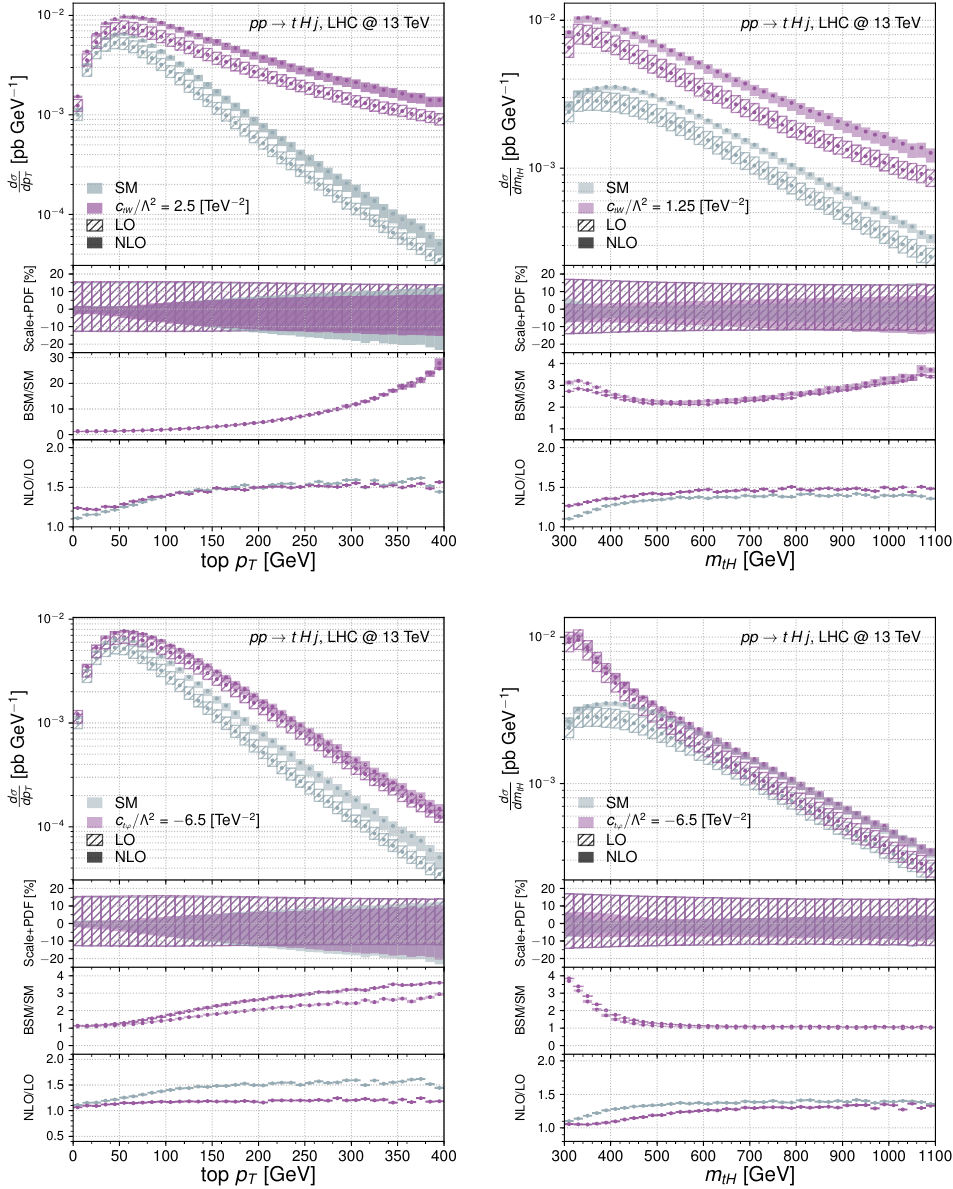
Figure 4 . Di(cid:11)erential distributions of the top p tHj process for given values of the individual, direct limits. The lower insets show the scale and PDF uncertainty bands, the ratio over the SM prediction and (cid:12)nally the corresponding K